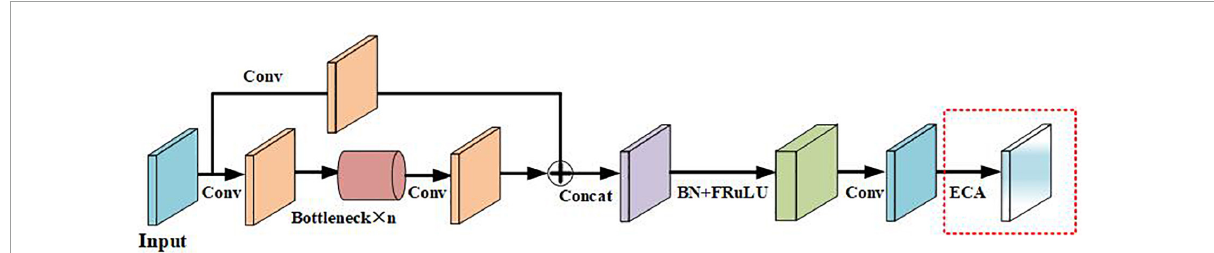
FIGURE5 Structure of improved C3 module.